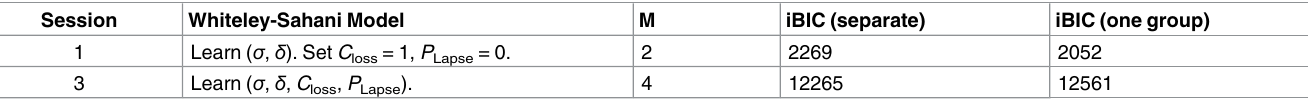
Table 2. iBIC scores for separated groups and one group. Session Whiteley-Sahani Model M iBIC (separate) iBIC (one group) 1 Learn ( σ , δ ). Set C loss = 1, P Lapse = 0. 3 Learn ( σ , δ , C loss , P Lapse